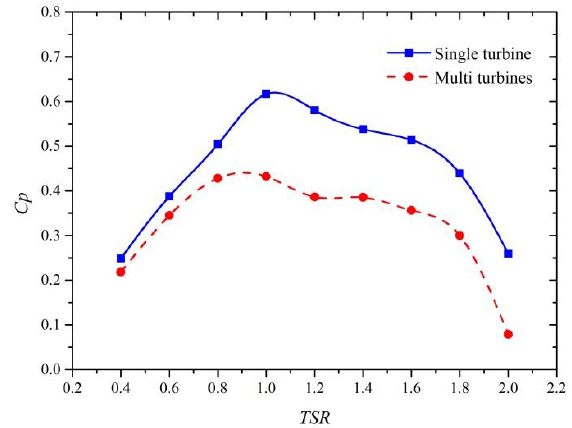
Figure 14. Effects of adjacent turbines on the power performance of the turbine.